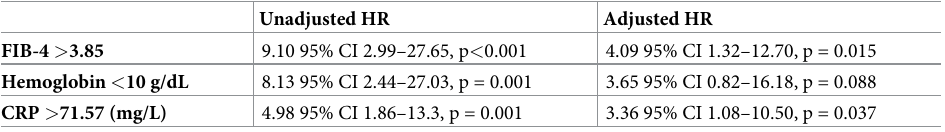
Table 2. The univariable and multivariable cox-regression analysis.